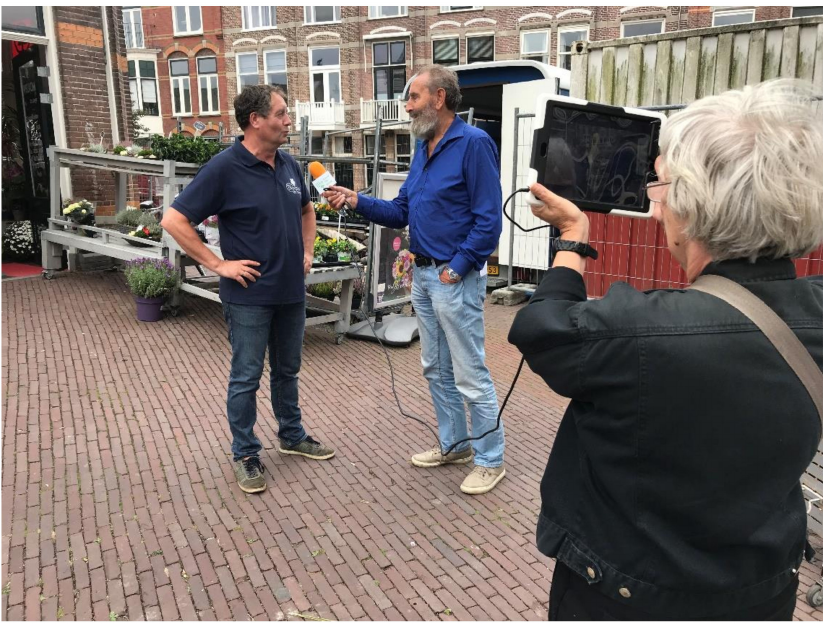
Figure 2. Interviewing a shop-owner in